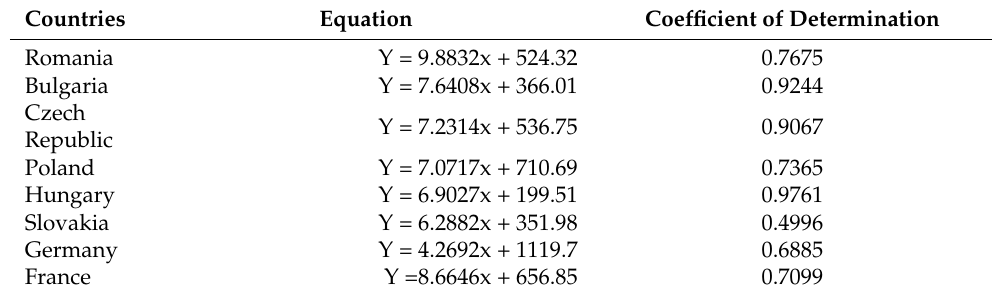
Table 2. Results of correlation analysis (2009–2020). Source: own calculation based on Eurostat.